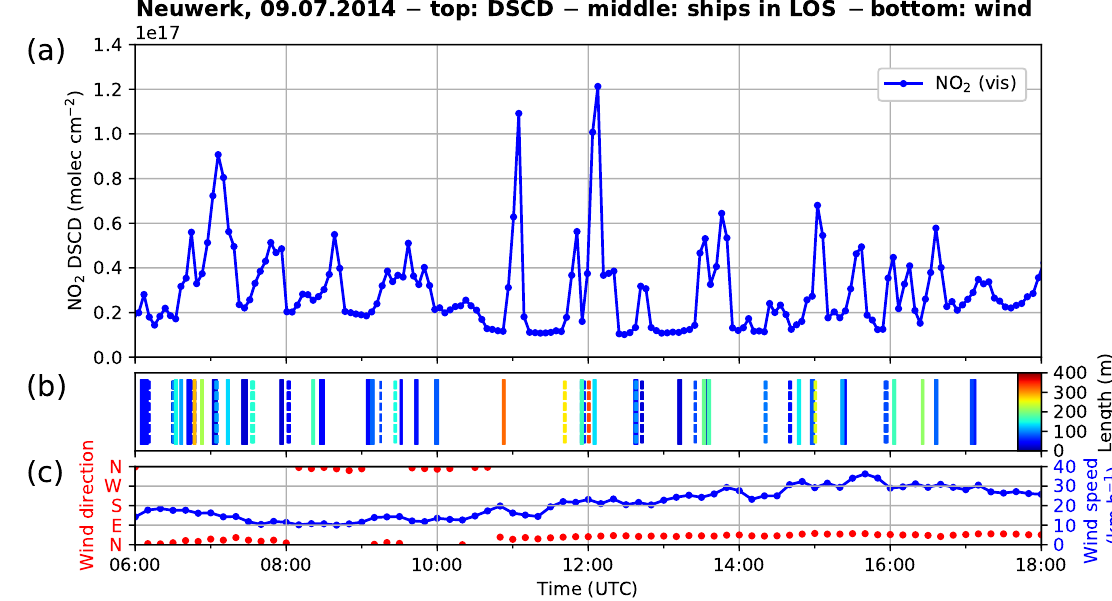
Figure 10. NO 2 differential slant column densities, AIS and wind data for Neuwerk on 9 July 2014. (a) NO 2 DSCD in 0.5 ◦ elevation for the 35 ◦ azimuth viewing direction. (b) Vertical bars indicating that a ship is in the line of sight of the instrument. Solid bars: ship moves from left to right (west to east); dashed bars: vice versa; colors represent ship length. (c) Wind speed and direction measured on Scharhörn